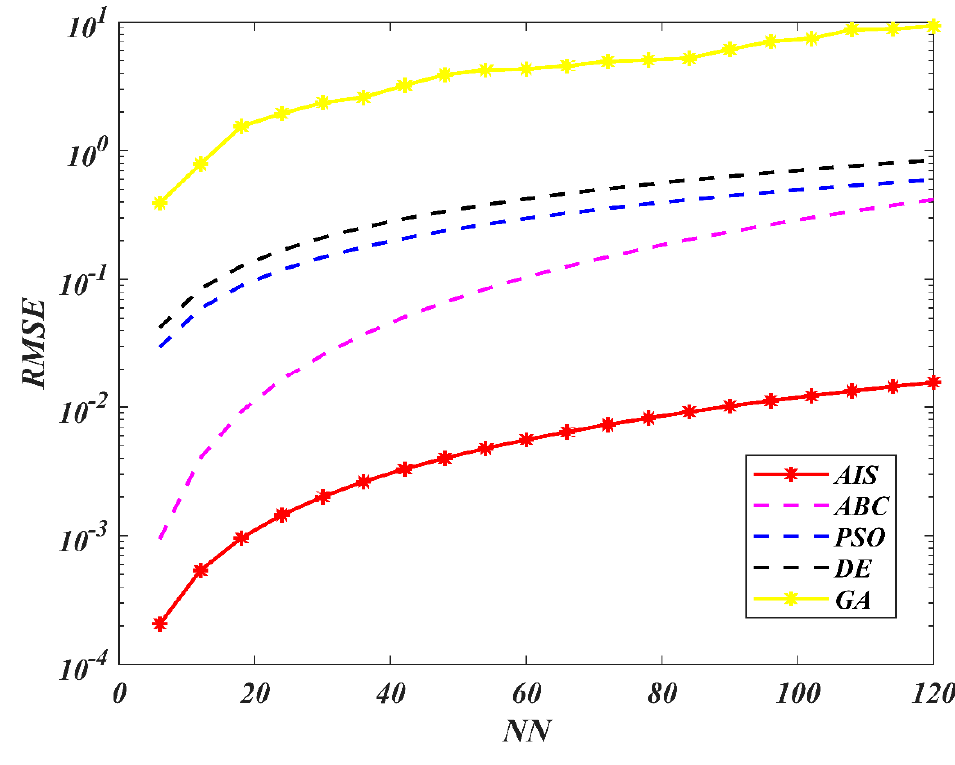
Processes 2020 , 8 , x FOR PEER REVIEW Figure 13. Root Mean Square Error (RMSE) Evaluation for German Credit. Figure 13. Root Mean Square Error (RMSE) Evaluation for German Credit.